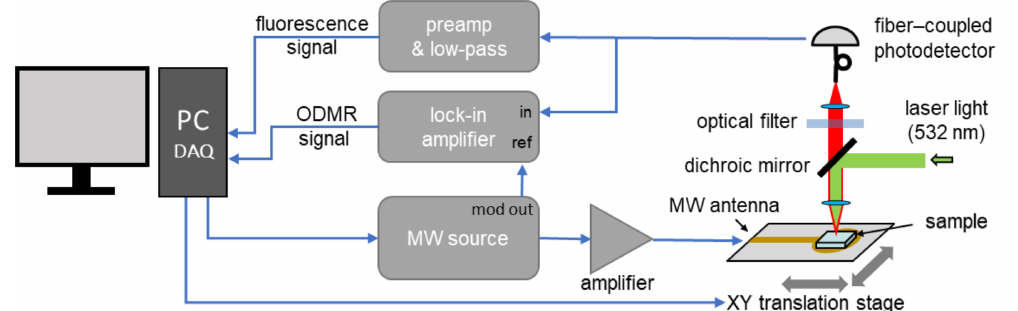
Figure 1. Schematic diagram of the experimental setup. A home-built confocal microscope is used for NV fluorescence detection. ND samples are placed on top of a loop-gap-type antenna and the magnetic resonance is observed for frequencies around 2.9